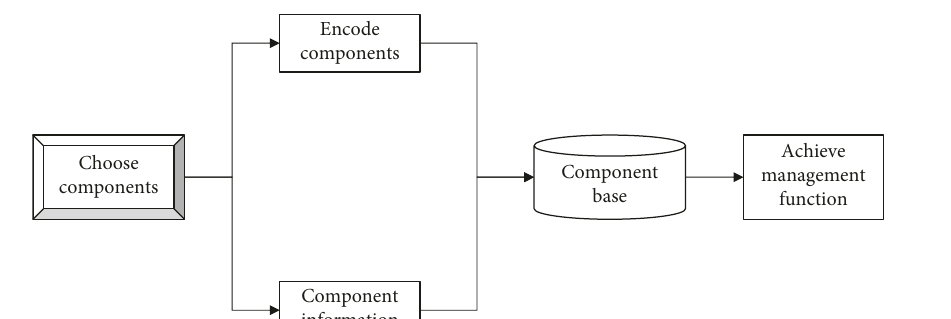
Figure 5: Process of building component base.